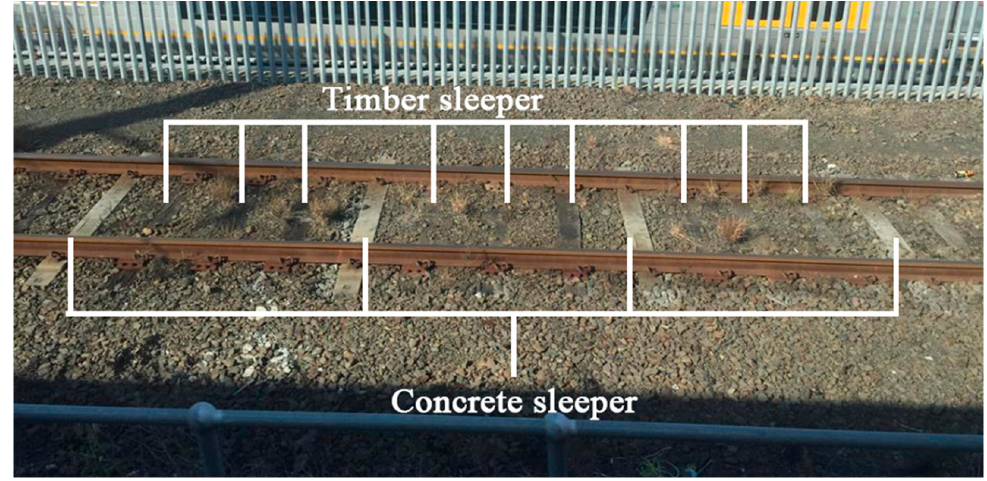
Figure 2. A 1in4 interspersed ballast track [12].